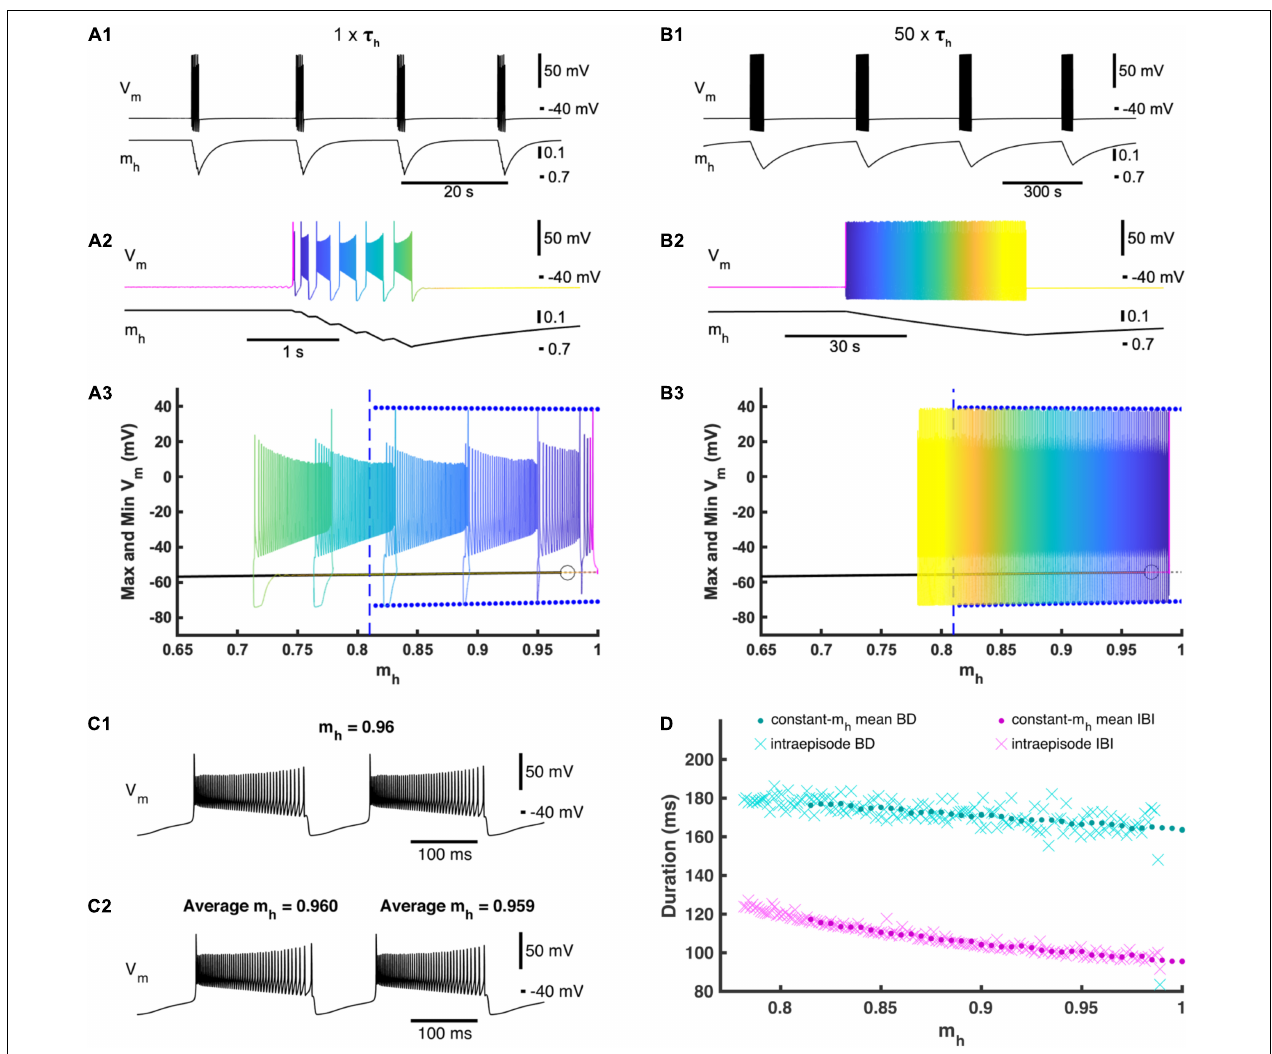
FIGURE 2 | Activation and deactivation of I h governs episodic bursting in the single cell model. (A1) A single cell in our full HCO model produces episodic activity when decoupled. (A2) Zooming in on intra-episode bursting in the single cell model. Color represents the phase within the episodic rhythm. (A3) Episodic activity of the full single-cell model is projected on the bifurcation diagram of the reduced constant- m h model where m h is treated as a parameter and varied. For each m h parameter value, the reduced model maximum and minimum membrane potential values for the bursting regime are marked by blue dots, while the silent regime in the reduced model is marked by a black line. The silent regime loses stability at the subcritical Andronov–Hopf bifurcation marked by an open circle. The gray dashed line depicts an unstable silent regime, and the beginning of this unstable regime. The value of m h where the bursting regime of the reduced model becomes unstable is marked by a vertical blue dashed line. The time course of the full single-cell model episodic activity can be seen by referencing the color map encoding phase defined in (A2) . (B1) Activity of the full single-cell model when τ h is scaled by multiplier factor 50 (50 × τ h ). (B2) Zooming in on a single episode to define the color map that represents the phase of this slower episodic rhythm. (B3) The slower episodic activity overlaid on the bifurcation diagram of the reduced constant- m h model, where again the color map represents phase as defined in (B2) . (C1) Example of the reduced model with m h = 0.96 to compare with (C2) . (C2) Zooming in on two consecutive bursts exhibited by the 50 × τ h full single cell model, where the first of these two bursts have an average m h value of 0.96 to be compared to (C1) . (D) Intra-episode burst characteristics from the 50 × τ h model (cyan and magenta Xs) versus the average m h across the corresponding burst cycle plotted with the mean burst duration (BD) and interburst interval (IBI) values of the reduced constant- m h model (cyan and magenta dots) versus the value set for the parameter m h .